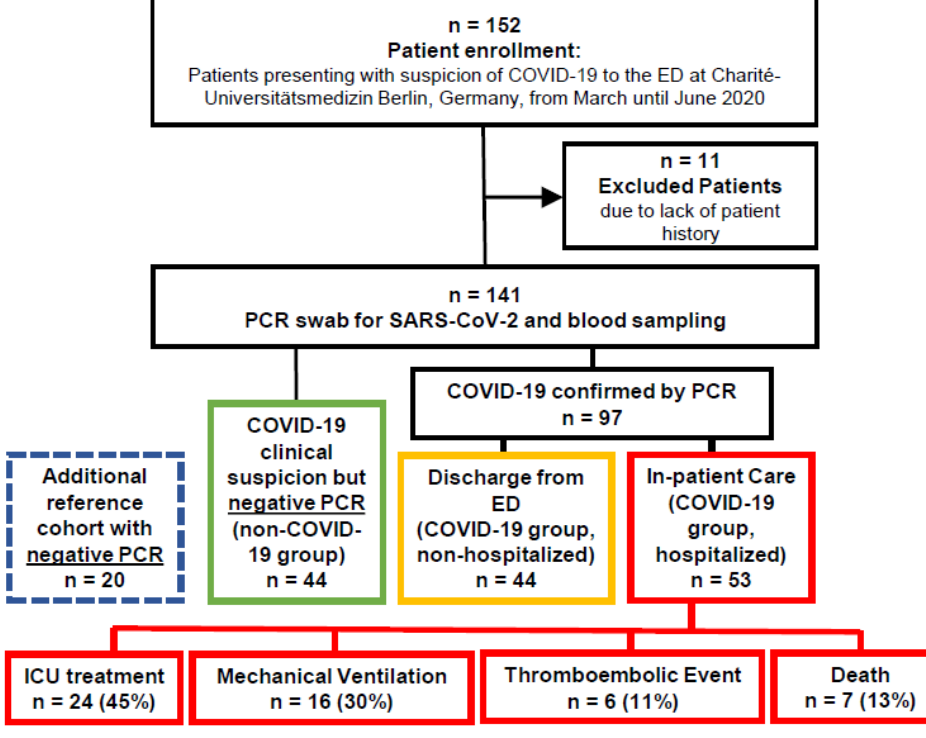
Figure 1. Study outline.